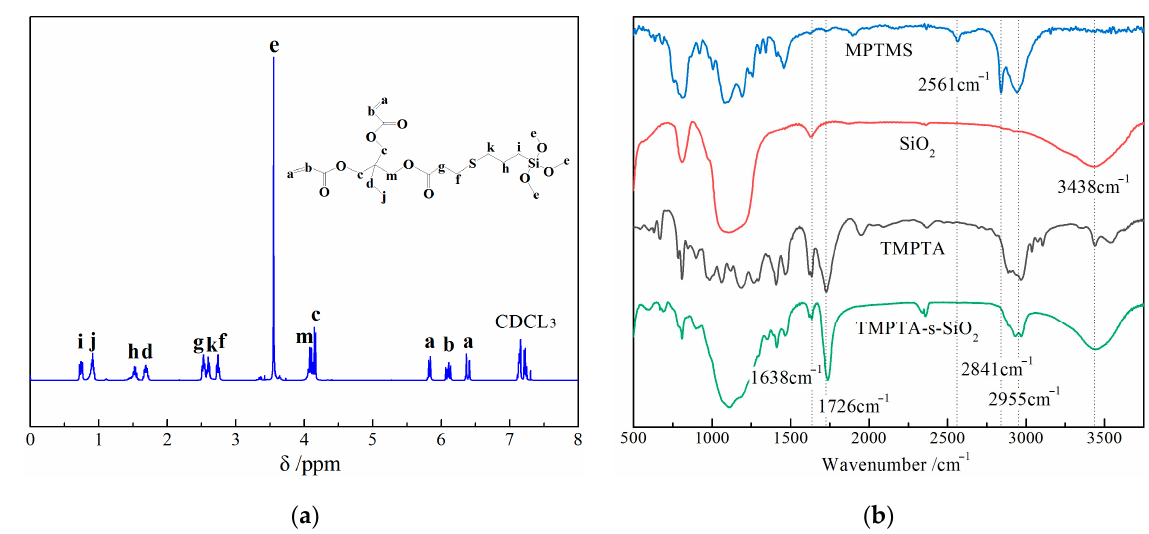
Figure 3. ( a ) Hydrogen nuclear magnetic spectrum of MTMPTA and ( b ) infrared transmission spectra of MPTMS, SiO 2 nanoparticles, TMPTA, and TMPTA-s-SiO 2 nanoparticles.